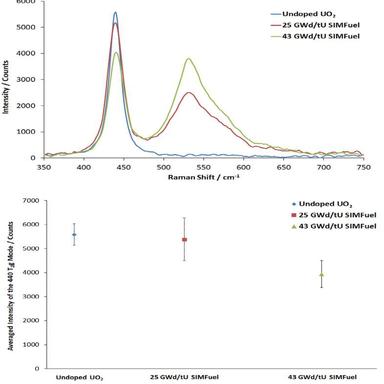
Average μRaman spectra recorded from undoped UO2, 25 GWd/tU SIMFuel and 43 GWd/tU SIMFuel samples over the range 350 to 750 cm−1 (top) and the fitted intensity of the 440 T2g peak from undoped UO2, 25 GWd/tU SIMFuel and 43 GWd/tU (bottom).